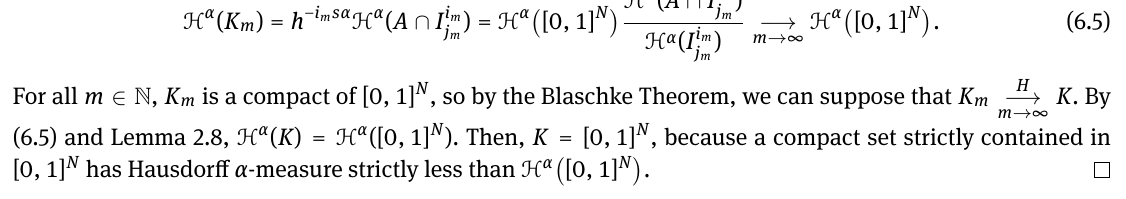
that does not intersect B ∩ B ( x , r j (cid:48) n